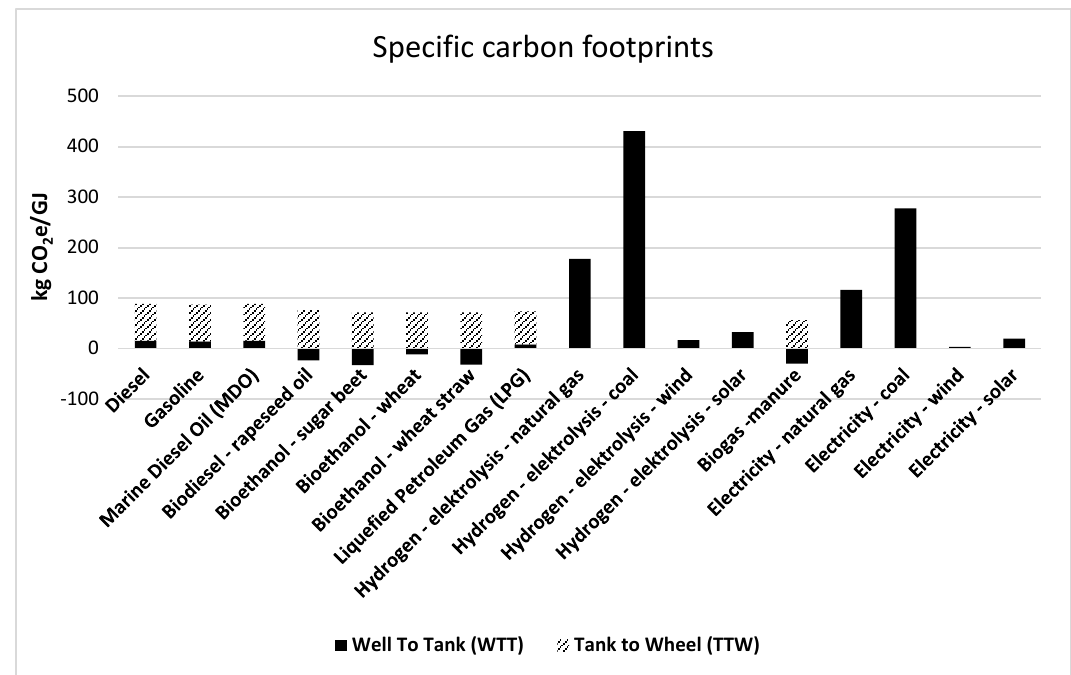
Figure 2. Specific carbon footprints of fuels, showing the well to tank (WTT) (emissions in the production chain of a fuel) and tank to wheel (TTW) (emissions during the combustion of a fuel) per gigajoule (GJ) of energy provided to the transport system (kg CO 2 /GJ).